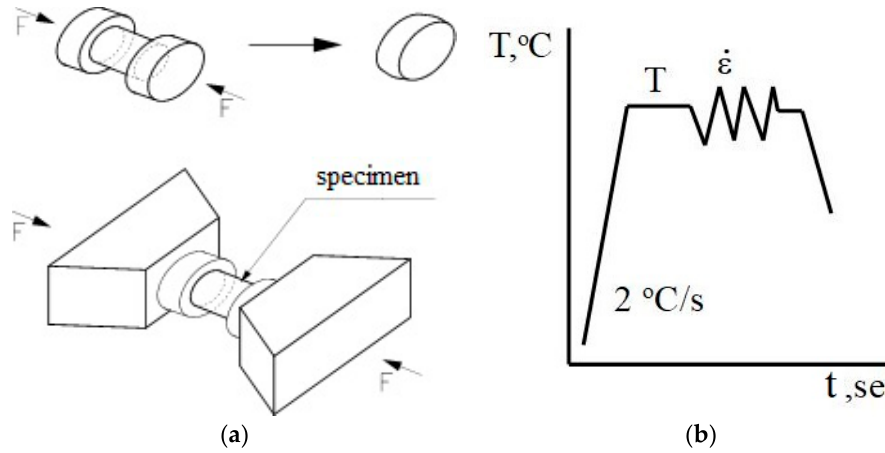
Figure 1. Geometry and dimension of load ( a ); and thermal cycle of physical simulation ( b ).